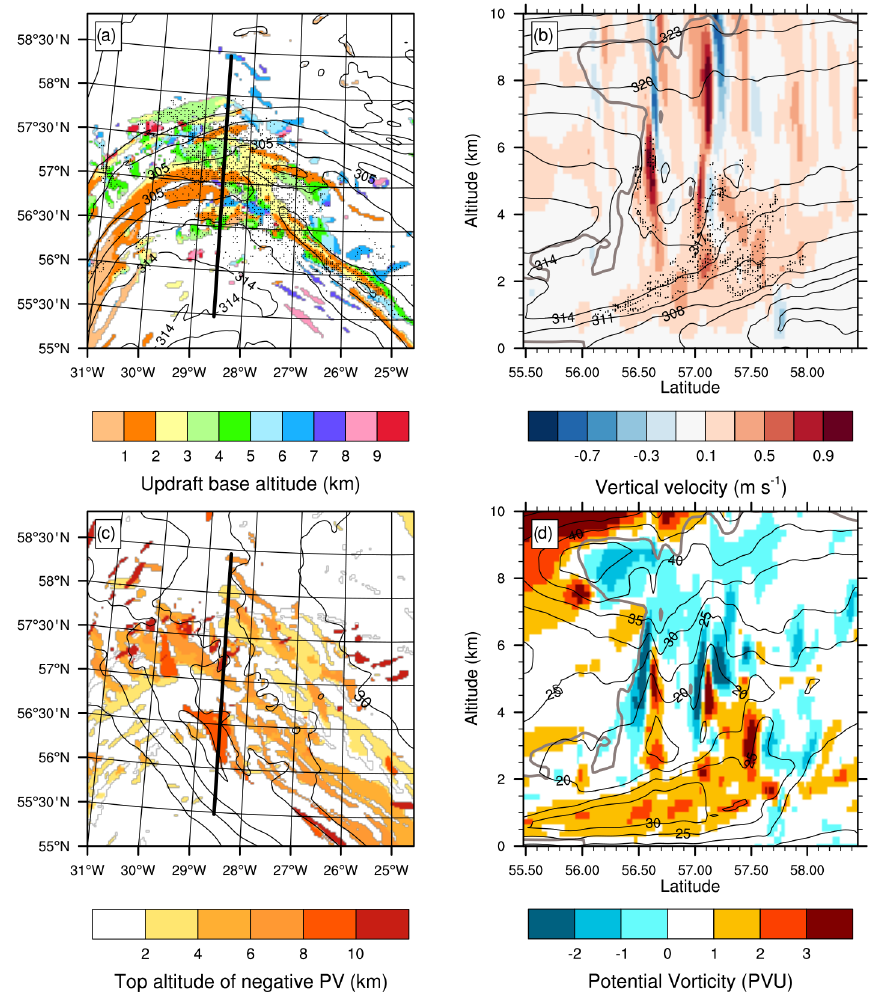
Figure 9. Results at 02:00UTC for the REF simulation. (a) Base altitude of updrafts (shading; in kilometers) and θ e at 1km height (black contours every 3K). (b) Vertical velocity (shading; in ms − 1 ), θ e (black contours every 3K) and cloud variables (thick gray contour above 0.1gkg − 1 ) along the vertical cross section illustrated in panel (a) . (c) Top altitude of negative PV structures (shading; in kilometers) and horizontal wind speed on the 320K level (contours every 5K above 30ms − 1 ). (d) PV (shading; in PVU), horizontal wind speed (black contours every 5K) and cloud variables (thick gray contour above 0.1gkg − 1 ) along the vertical cross section illustrated in panel (b) . Dots (a, b) indicate the location of rapid anticyclonic segments, reduced to one for every 10, in panel (a)